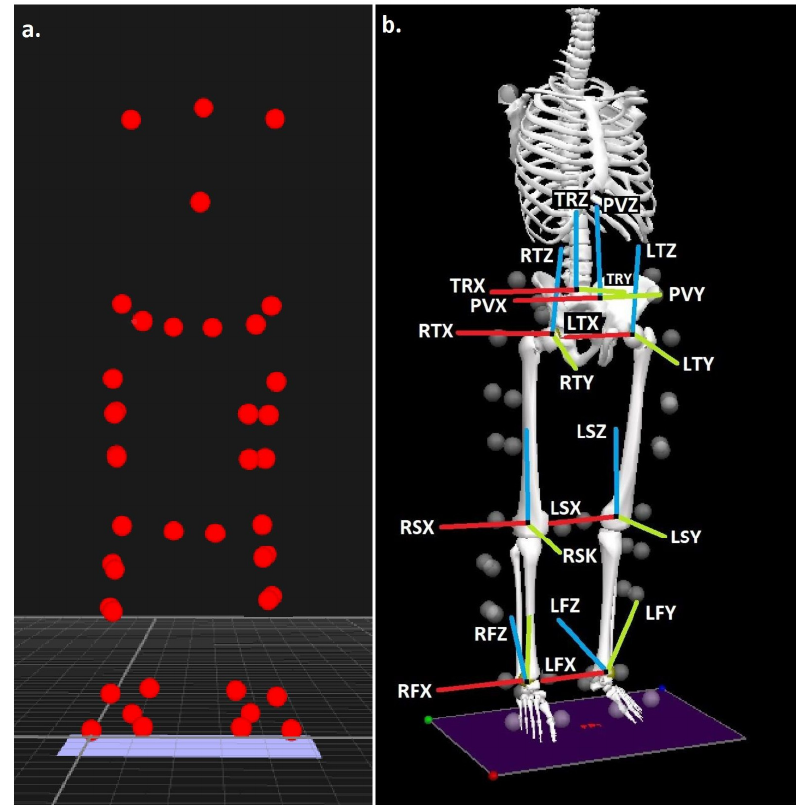
Figure 1. ( a ) Experimental marker locations and ( b ) trunk, pelvis, thigh, shank and foot segments, with segment co-ordinate system axes (R = right and L = left), (TR = trunk, P = pelvis, T = thigh, S = shank and F = foot), (X = sagittal, Y = coronal and Z = transverse